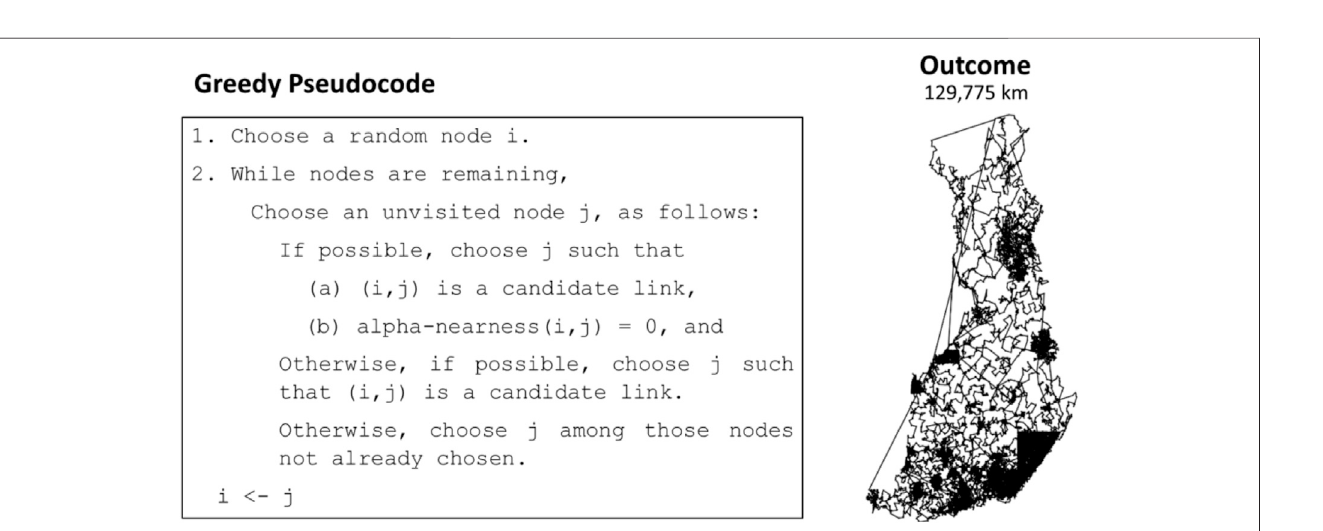
FIGURE 9 | Greedy algorithm used by LKH and the result on the Santa